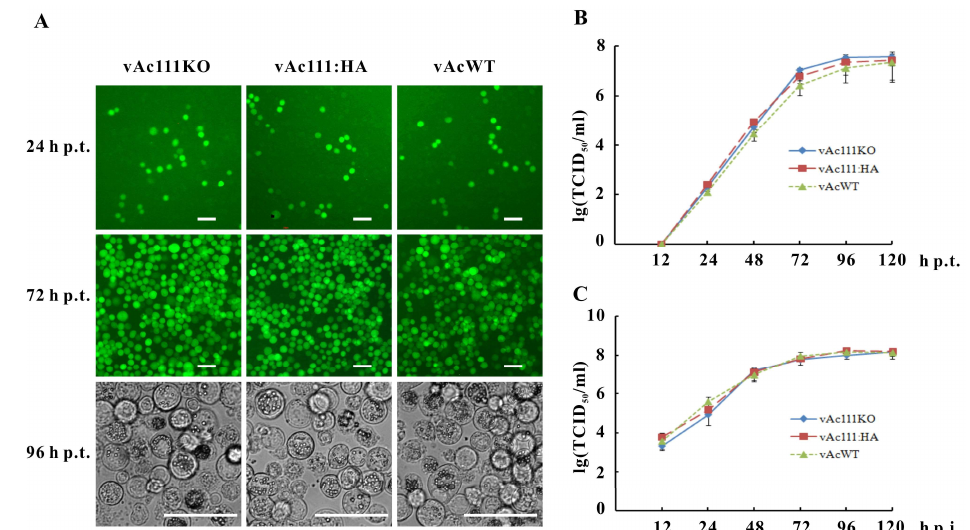
Figure 3. Analysis of viral replication. ( A ) Microscopic analyses of Sf9 cells transfected with vAc111KO, vAc111:HA, or vAcWT bacmid DNA. Fluorescence microscopy revealed the progress of